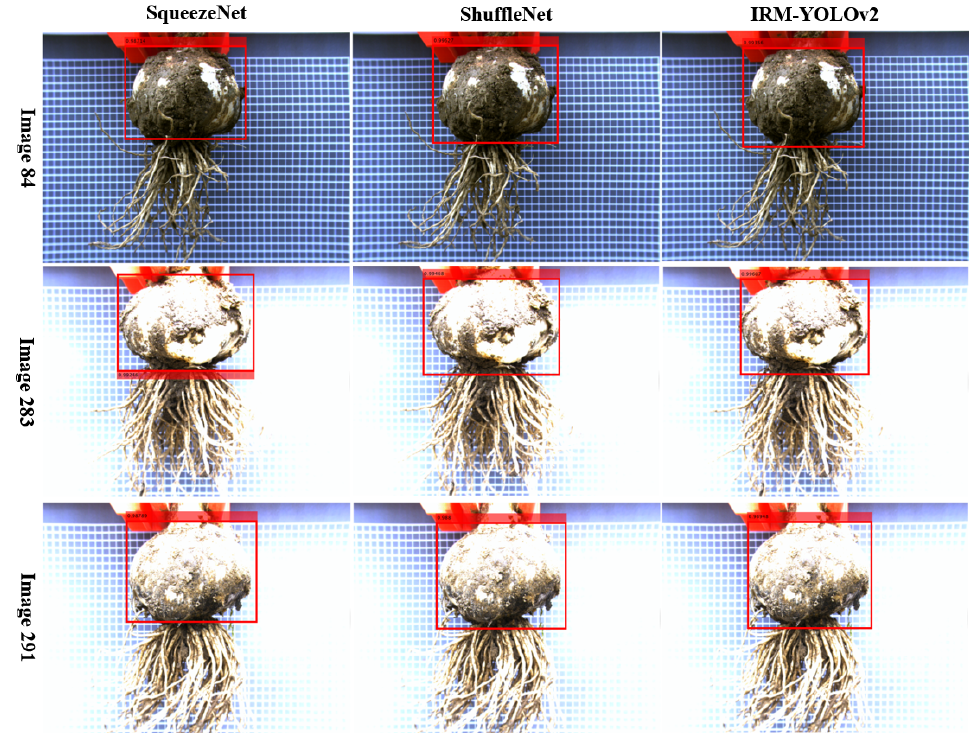
Figure 14. Prediction of cutting line location by different backbone networks.